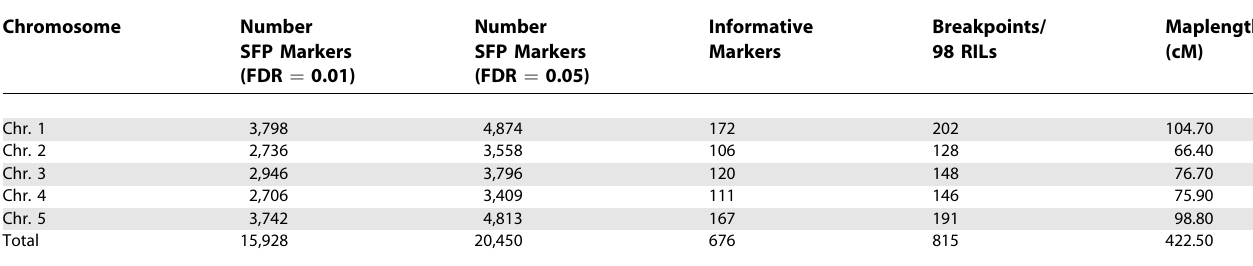
Table 1. Genetic Linkage Map Characteristics and SFP Marker Summary for the 98 Col/L er RILs Chromosome Number SFP